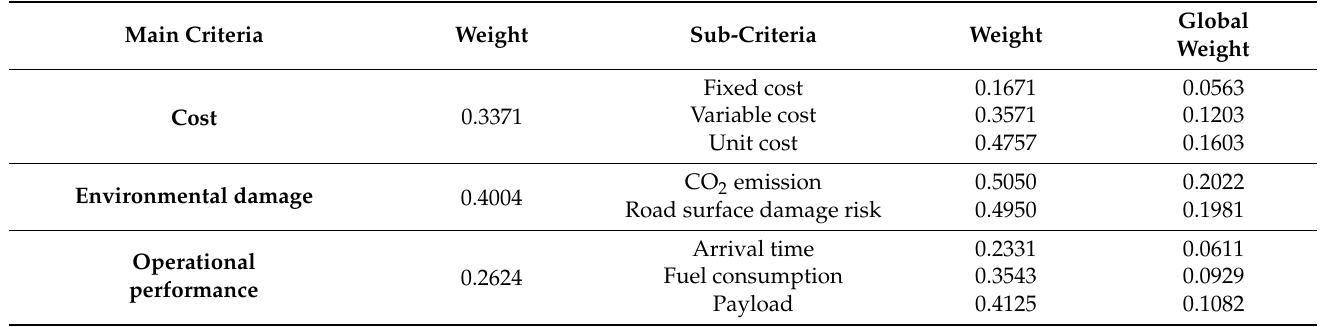
Table 7. Main criteria and sub-criteria weight and global weight values.